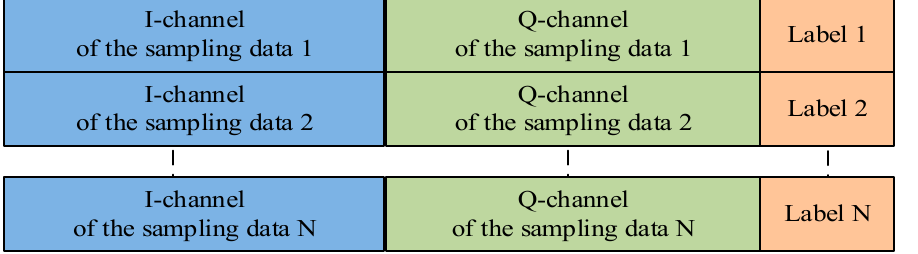
Figure 6. Dataset structure.